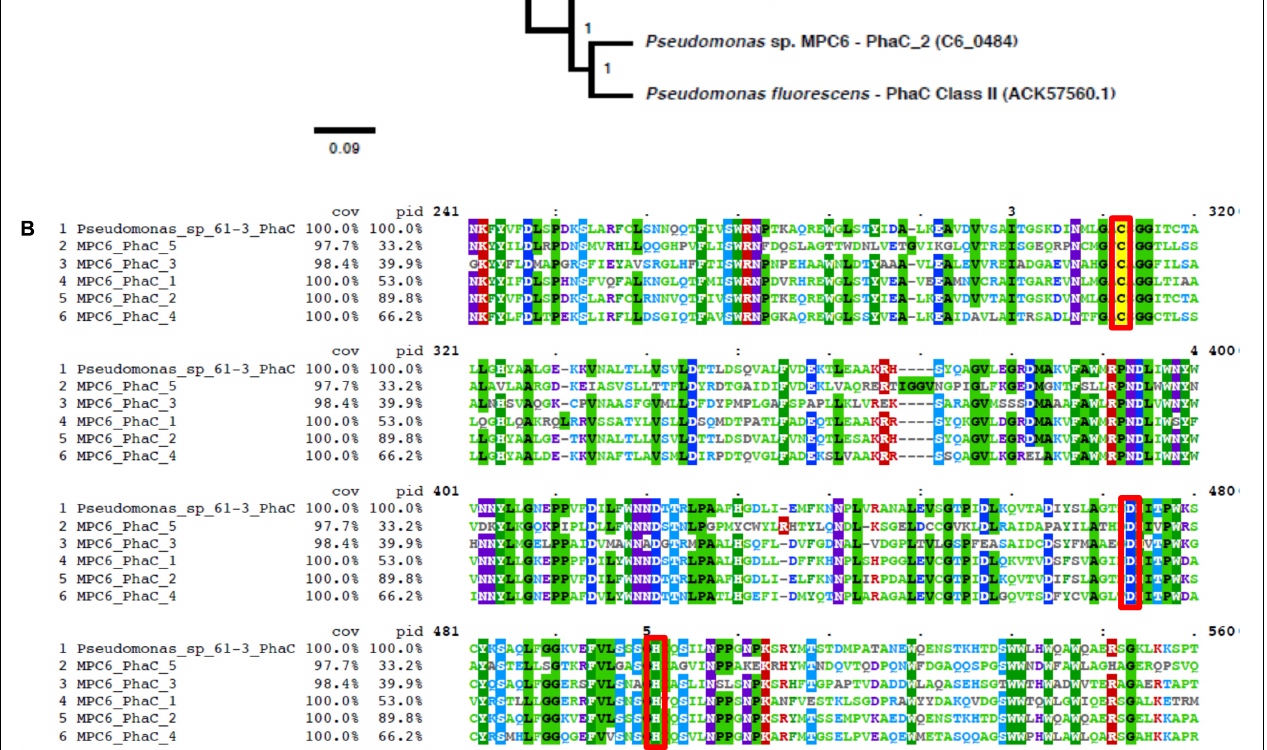
FIGURE 8 | PhaC synthases comparison of various PHA-producing microbes. (A) Phylogenetic three of different PhaC synthases. (B) Amino acid sequence alignment of various PhaC synthases.